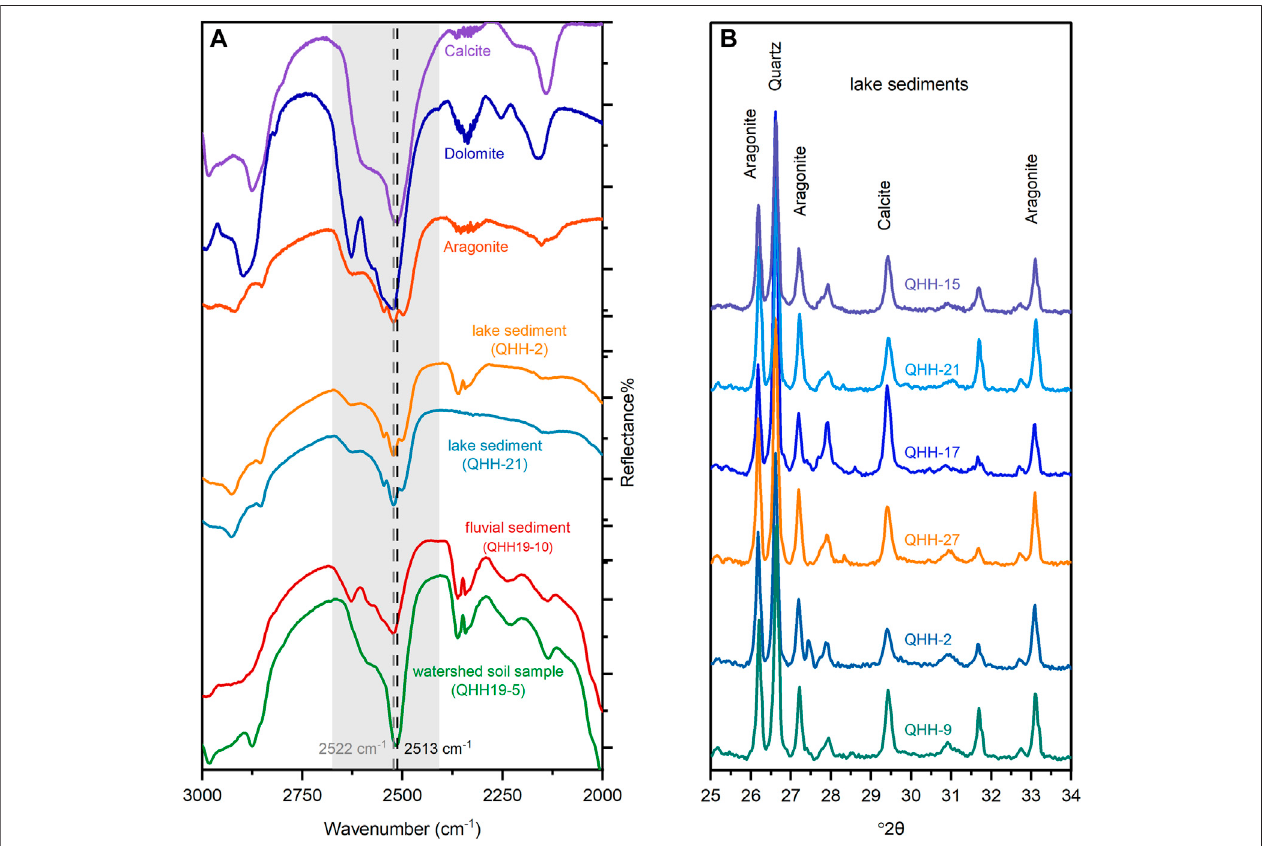
FIGURE 2 | FTIR and XRD analyses on Lake Qinghai sediments and watershed fl uvial sediments. (A) FTIR spectrum of pure standard calcite, dolomite, aragonite mineral, of samples in the lake sediments (QHH-2 and QHH-21), and of samples in the watershed fl uvial sediments (QHH19-10 and QHH19-5). Lake sediments have similar FTIR spectrum features with pure aragonite rather than calcite and dolomite, while watershed samples show a FTIR spectrum feature close to calcite or dolomite rather than aragonite. (B) XRD results of lake sediments (QHH-2, QHH-9, QHH-15, QHH-17, QHH-21, and QHH-27) also indicate that aragonite is the main component of carbonate mineral and followed by